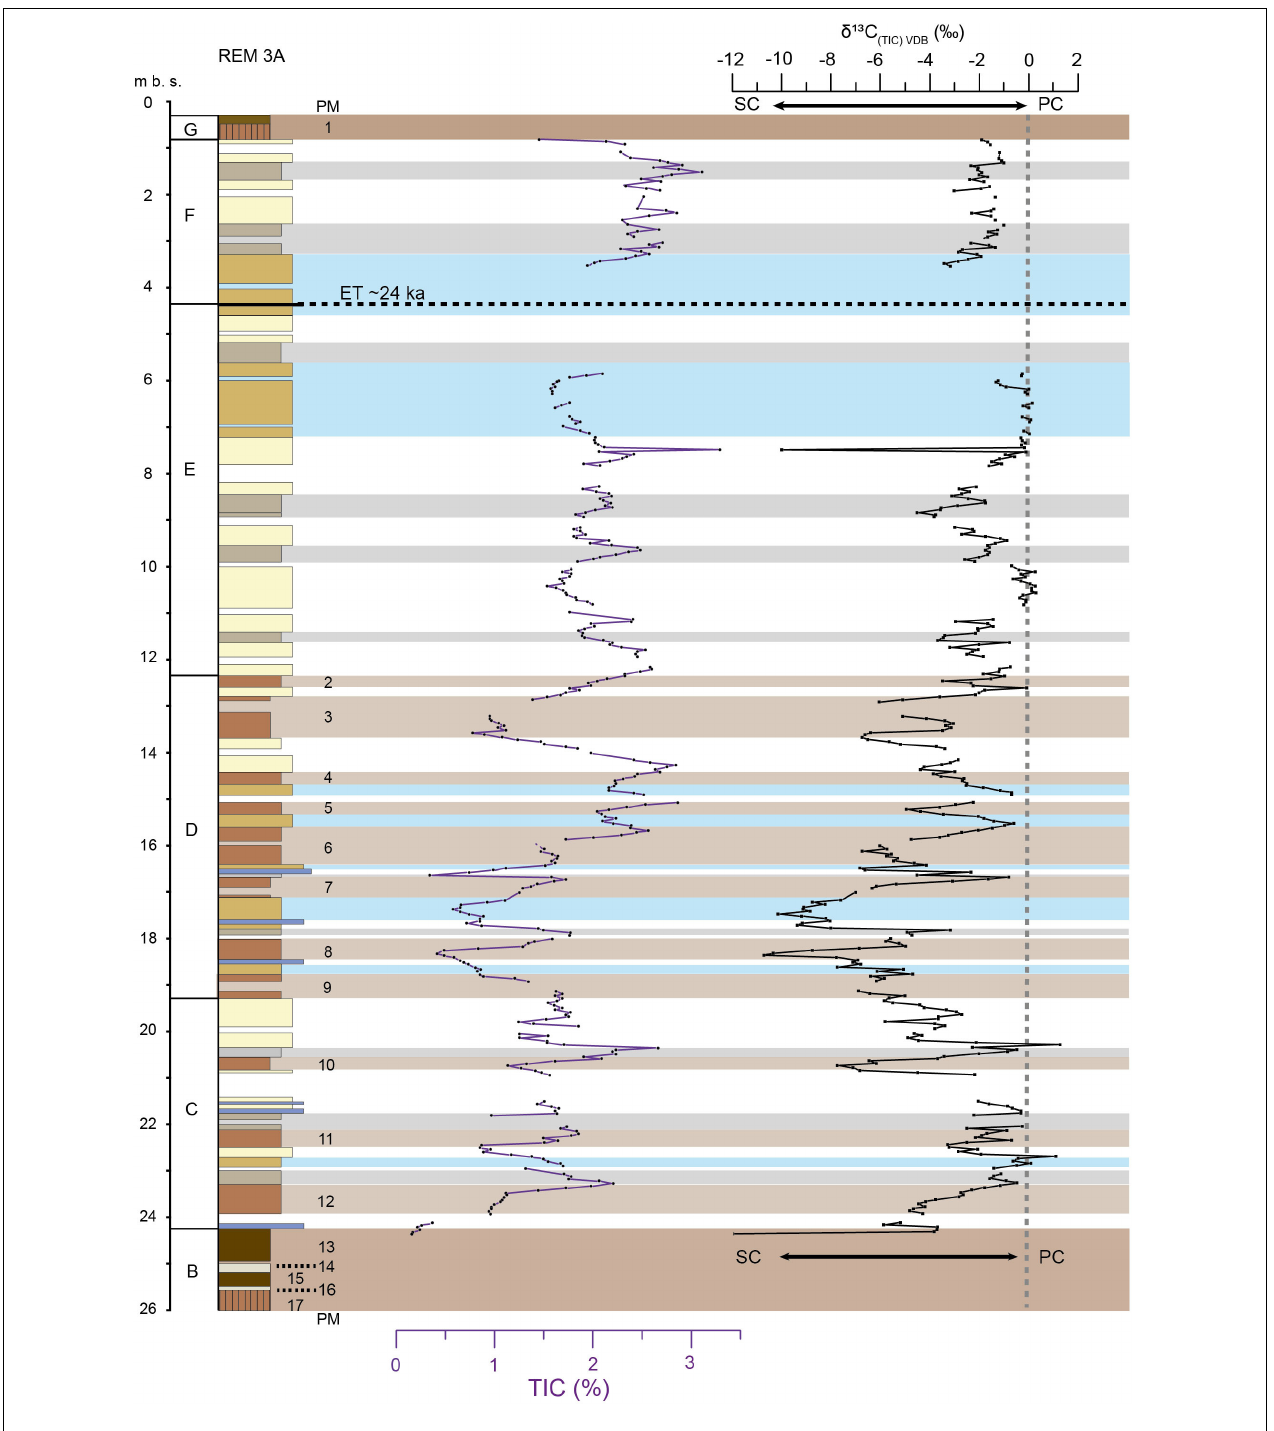
FIGURE 4 | Total inorganic C [TIC; (left, purple)] and its calculated stable C isotope composition [ δ 13 C ( TIC ) VPDB ; (right, black)] where more depleted δ 13 C values point toward enhanced SC concentration and values close to 0 indicate dominance of PC. Absolute minima in both curves are connected to pedogenic members (PM, see Figure 3 ) and occur locally in reworked loess layers (blue bars) indicating additional depletion processes. Gelic Gleysols are indicated by grey bars, Calcaric Cambisols by light brown bars and soil horizons associated with interglacial and early glacial conditions are represented by dark brown bars. Note that the lowermost part of unit (B) and the entire Holocene topsoil (A) are decalcified. Thus, no values are depicted. Estimated age of the Eltville-Tephra according to Zens et al. (2017) and Förster et al. (2020). Litho- and pedostratigraphic legend according to Figure 3 .